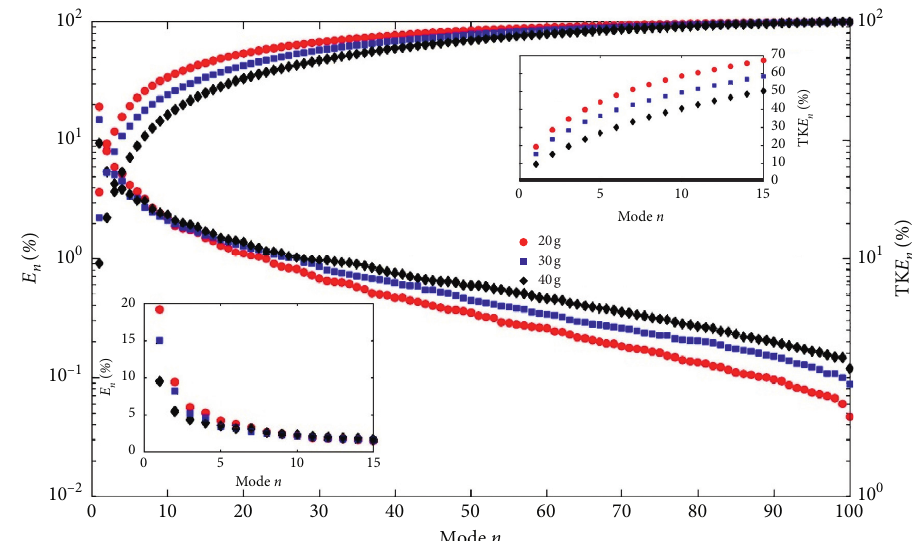
Figure 6: Energy distribution of POD modes under different fill levels at 40g oscillation acceleration.